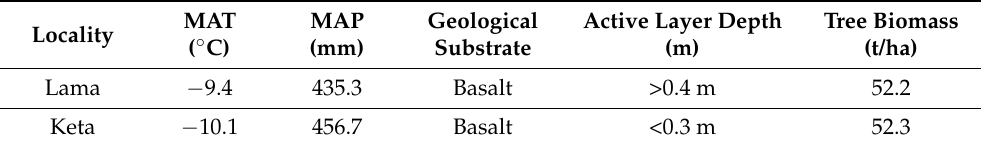
Table 1. Basic characteristics of the research localities. Mean annual temperature (MAT) and mean annual precipitation total (MAP) were calculated from the CRU TS Monthly High-Resolution Gridded Multivariate Climate Dataset v. 4 [20].